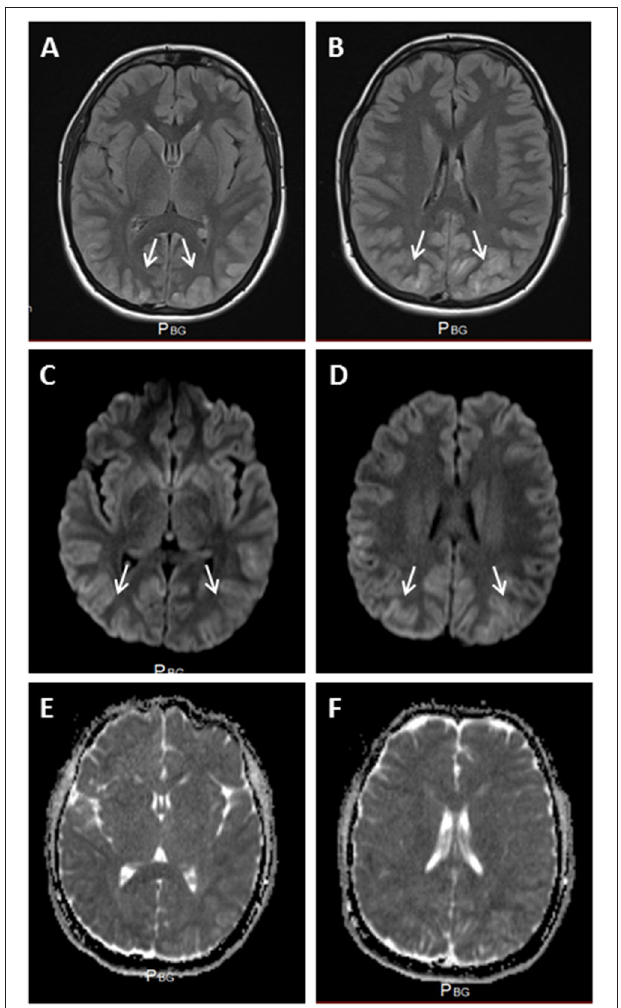
FIGURE 1 | (A,B) FLAIR MRI, showing bilateral hyperintensities in the occipital lobes, with cortical edema (white arrows). Hyperintense areas were also apparent in diffusion-weighted sequences (C,D) (white arrows), with no apparent diffusion restriction (E,F)